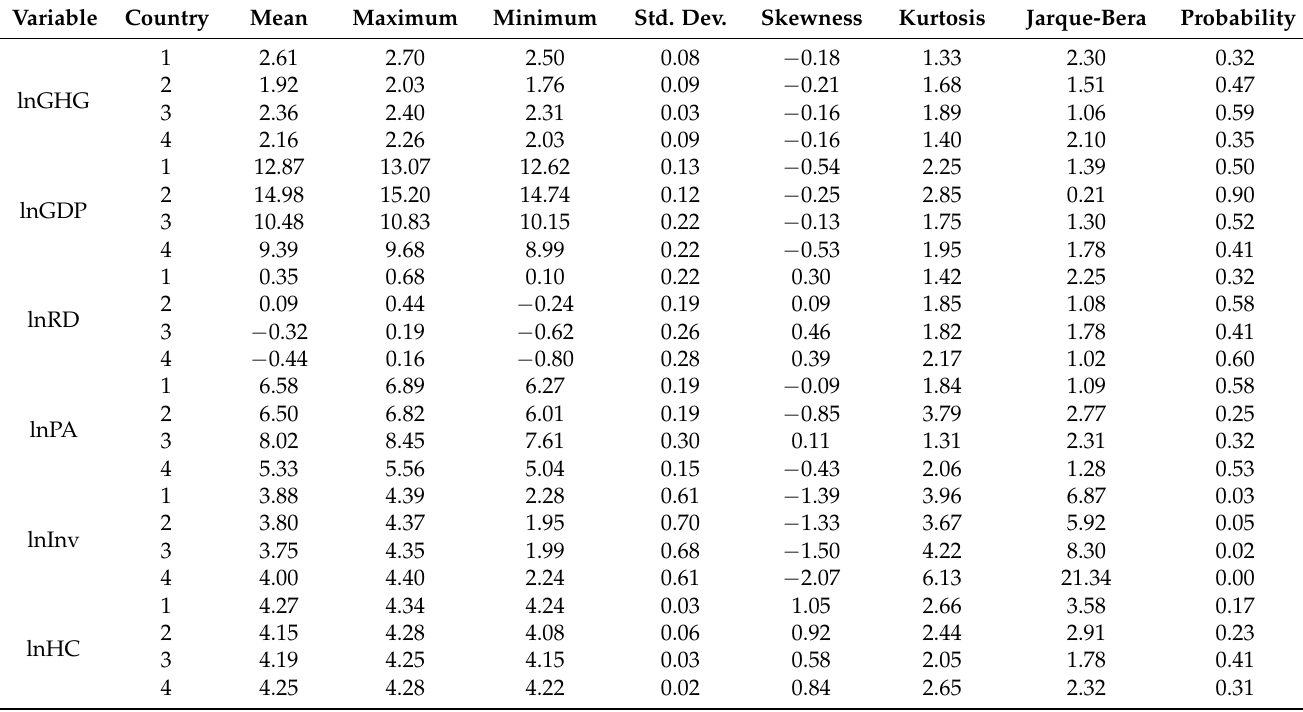
Table 3. Descriptive statistics for GHG, GDP, RD, PA, Inv, FDI,